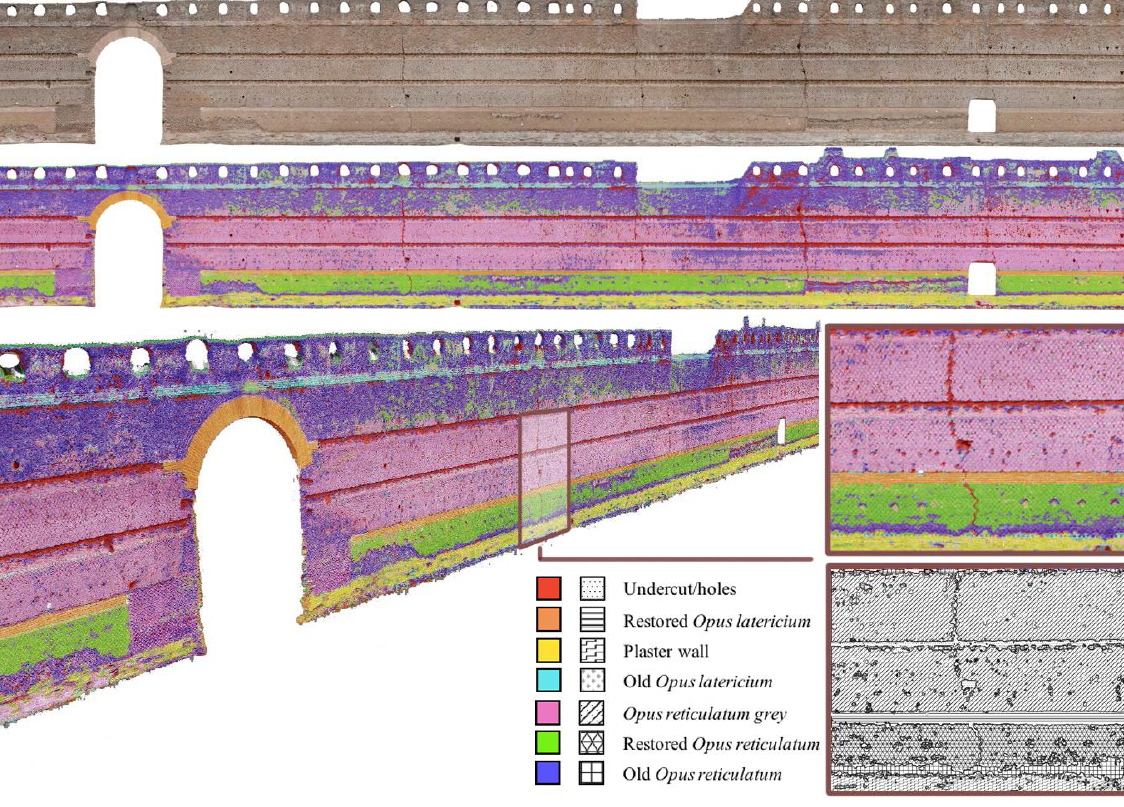
Figure 6: The original and classified orthoimage of a longer part of the Pecile’s wall long ca 60 m (a). Classification results mapped onto the 3D model of the wall (b). A closer view is also reported to better show the classification results with random colours or dedicated symbols.